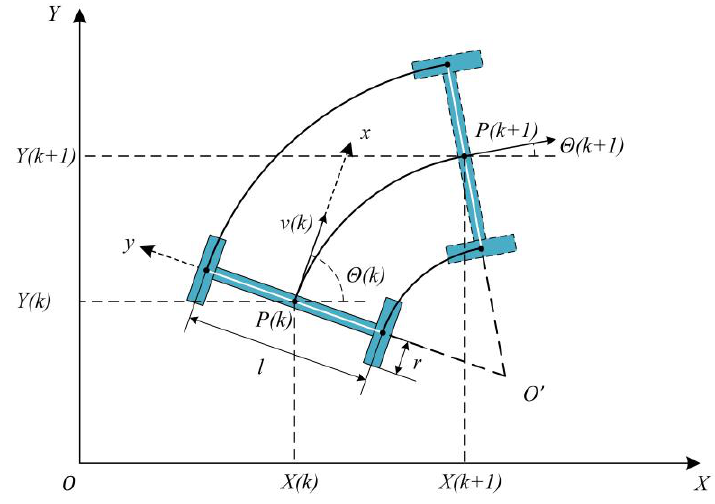
Figure 8. Schematic diagram of AGV kinematics.